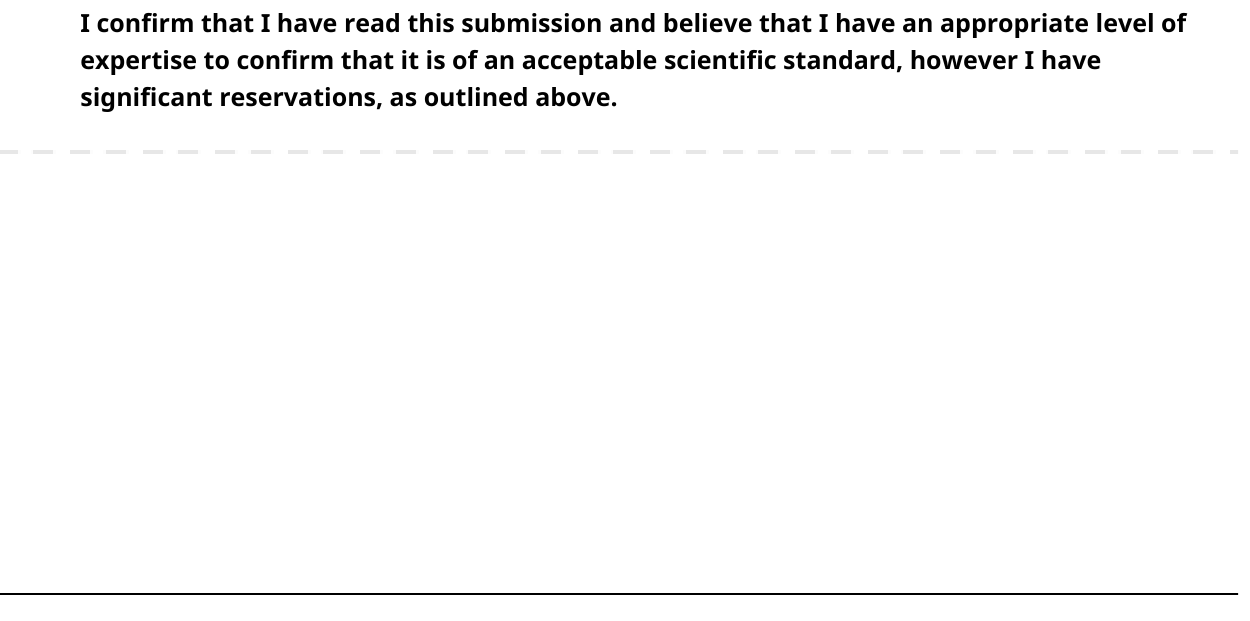
Figure 1. legend should read "bowel", rather than